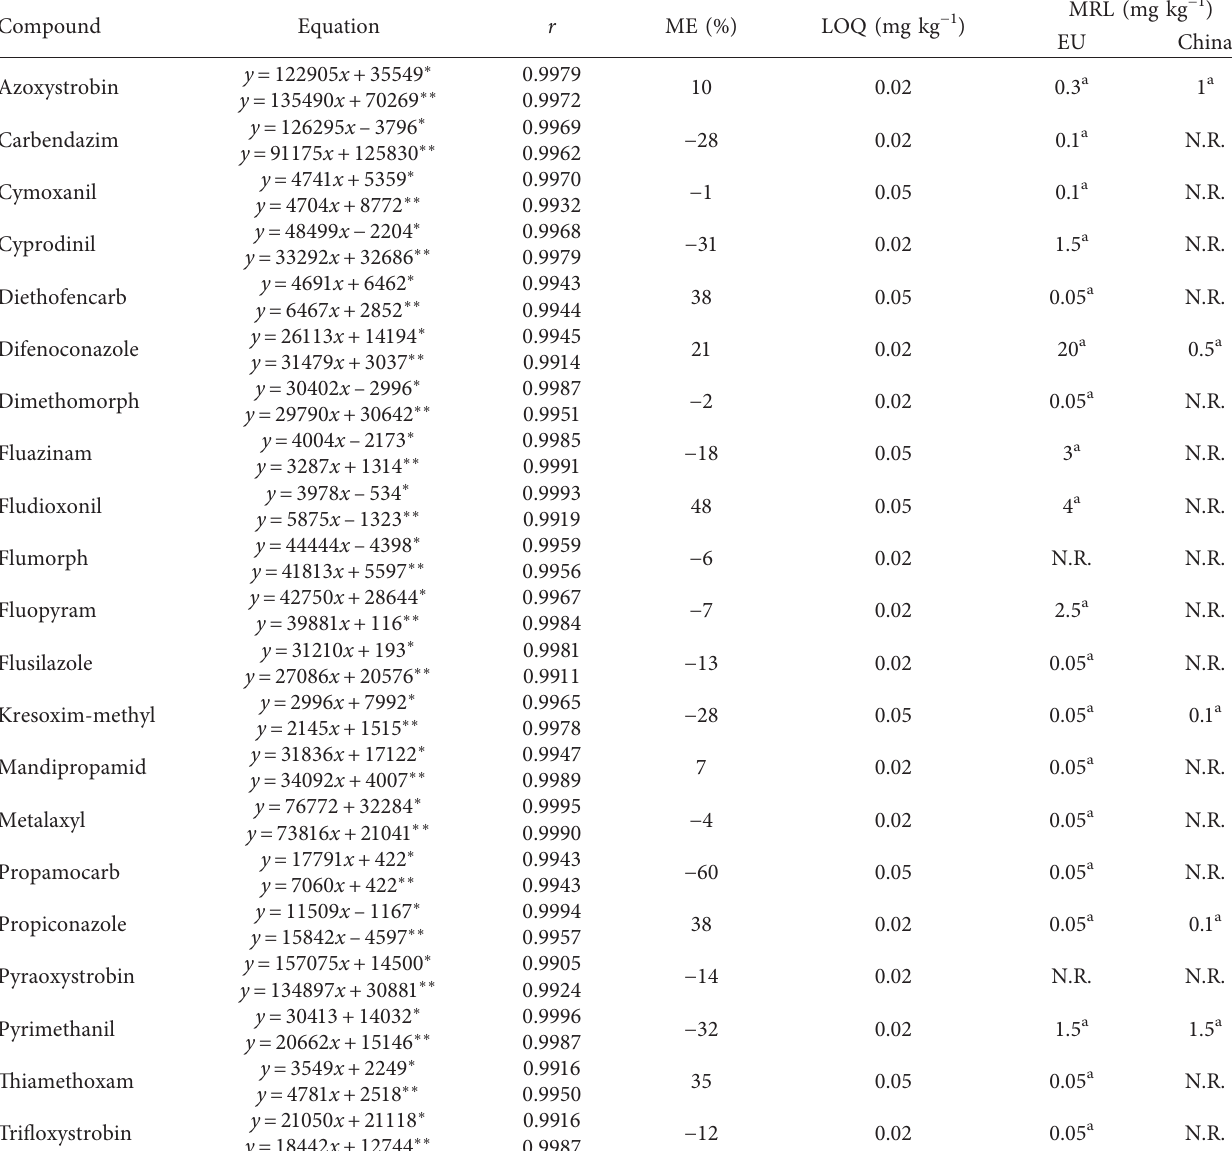
Table 2: Calibration information, matrix effects (ME), limits of quantitation (LOQs), and maximum residue limits (MRLs) of 21 pesticides in ginseng